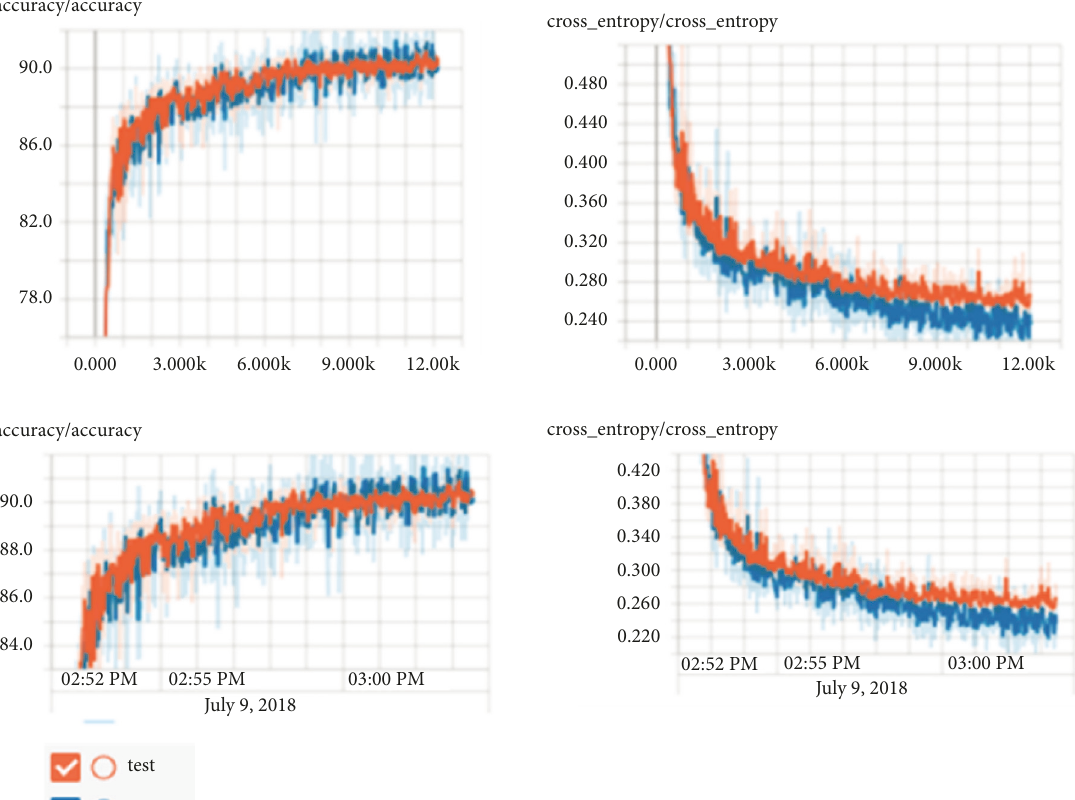
Figure 9: The accuracy and cross-entropy of the model with the weights of re-sample set to average and the hidden size set to 250.